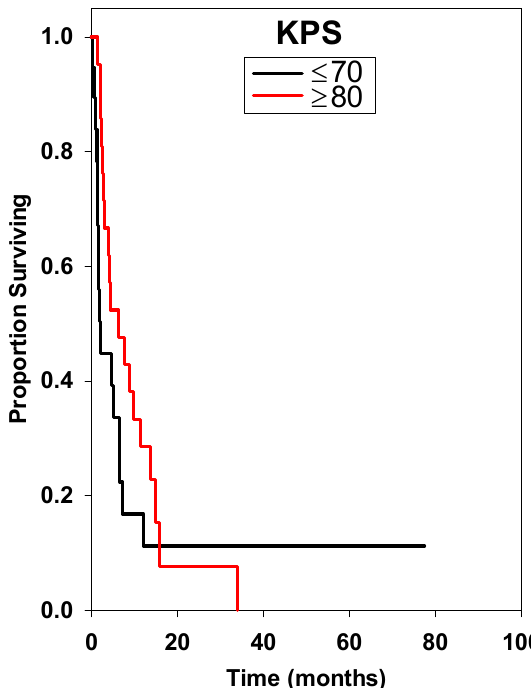
Figure 6. Survival curve considering Karnofsky performance score (KPS). There was a statistically significant difference with better survival in patients with KPS ≥ 80 ( p = 0.019) after multivariate analysis.